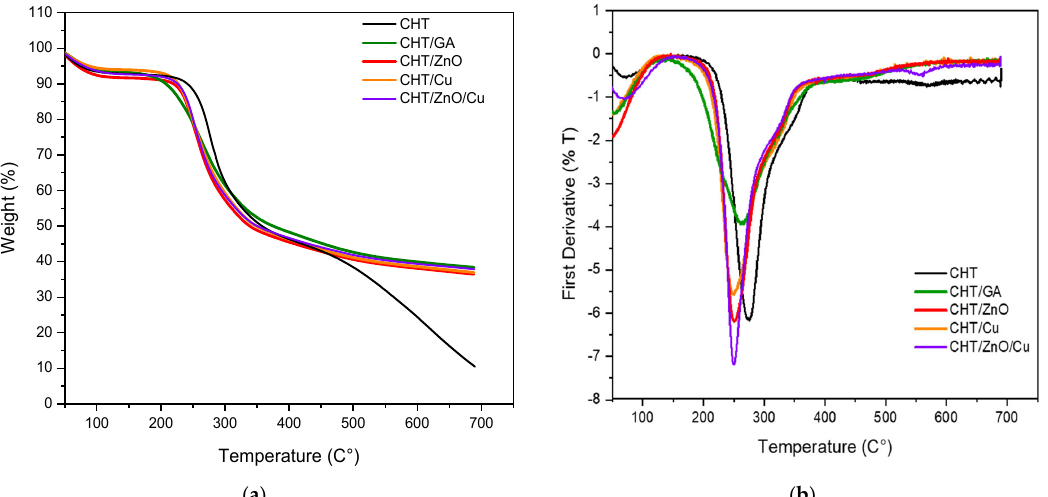
Figure 3. TGA ( a ) and DTGA ( b ) thermograms of chitosan crosslinked GA (CHT/GA) chitosan with zinc oxide (CHT/Zn ‐ O), chitosan with copper nanoparticles (CHT/Cu), and chitosan with zinc oxide/copper nanoparticles (CHT/Zn ‐ O/Cu). Table 2. Decomposition temperatures and weight loss and residual mass at 700 °C of CHT films,